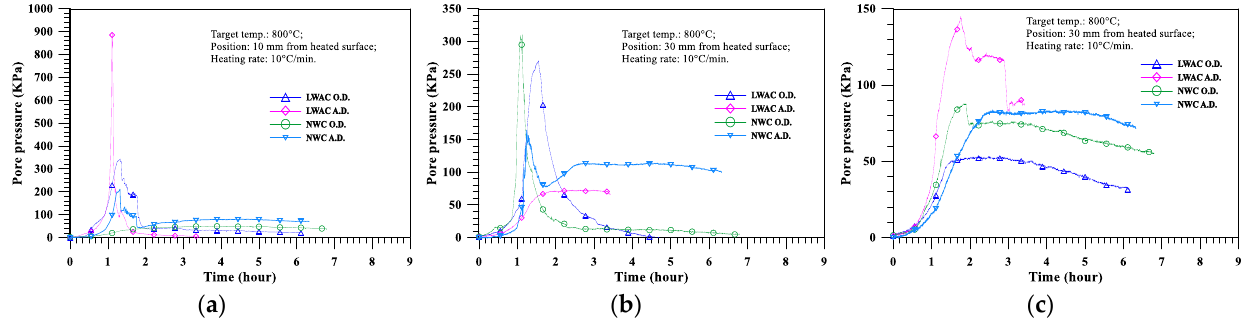
Figure 27. Effect of the moisture content on the pore pressure of the specimens performed at a target temperature of 800 °C and heating rate of 10 °C/min: ( a ) 10; ( b ) 30; ( c ) 50 mm depths.